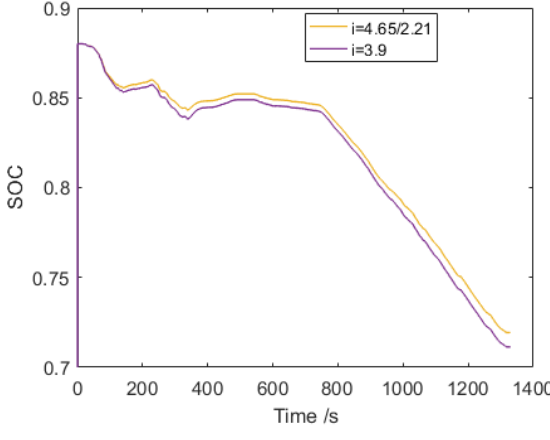
Figure 16. SOC comparison. Figure 16. SOC